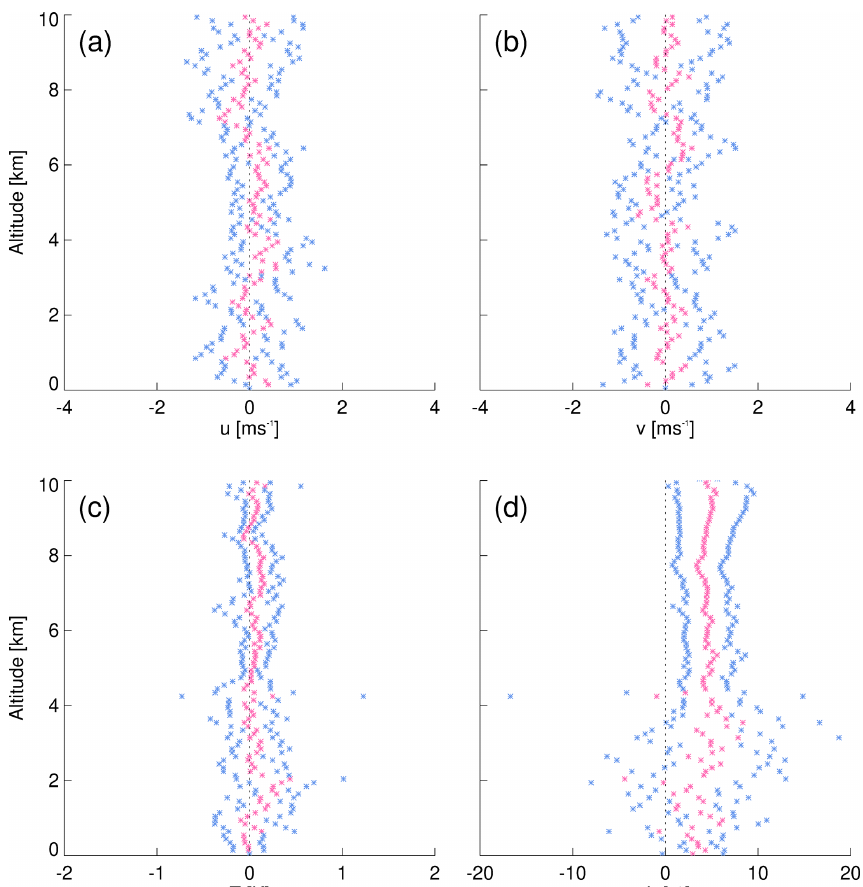
Figure A3. For Atalante soundings launched within ± 25min, the mean difference Meteomodem − Vaisala (pink) and ± 1 standard devi- ation (blue) computed on eight difference profiles with a vertical resolution of 100m. Shown are difference profiles for (a) zonal wind, (b) meridional wind, (c) temperature, and (d) relative